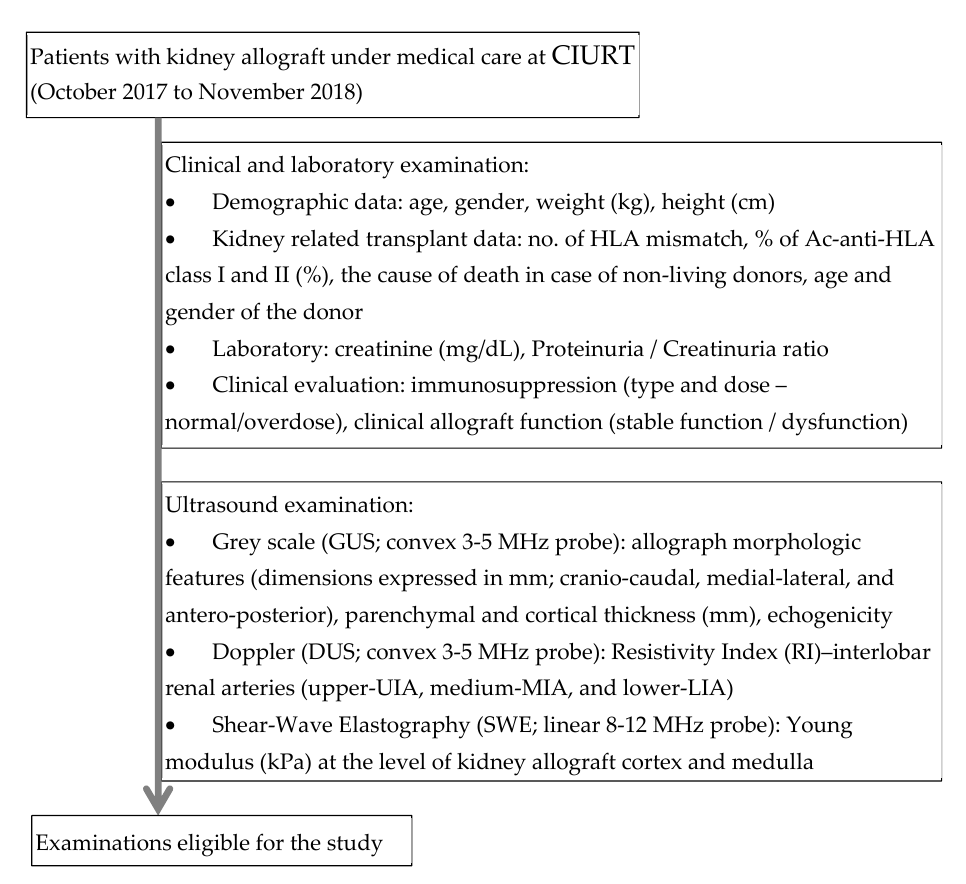
Figure 1. Study design flow: clinical and ultrasound examinations.